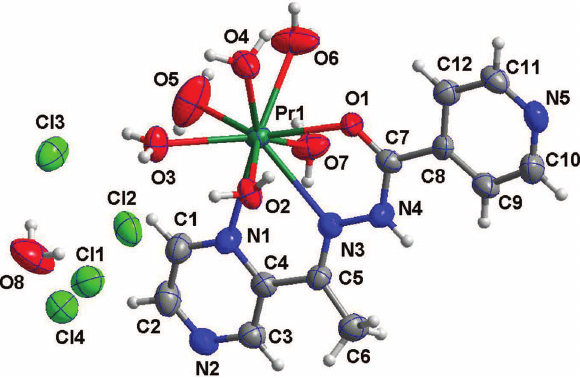
Table 2: Fractional atomic coordinates and isotropic or